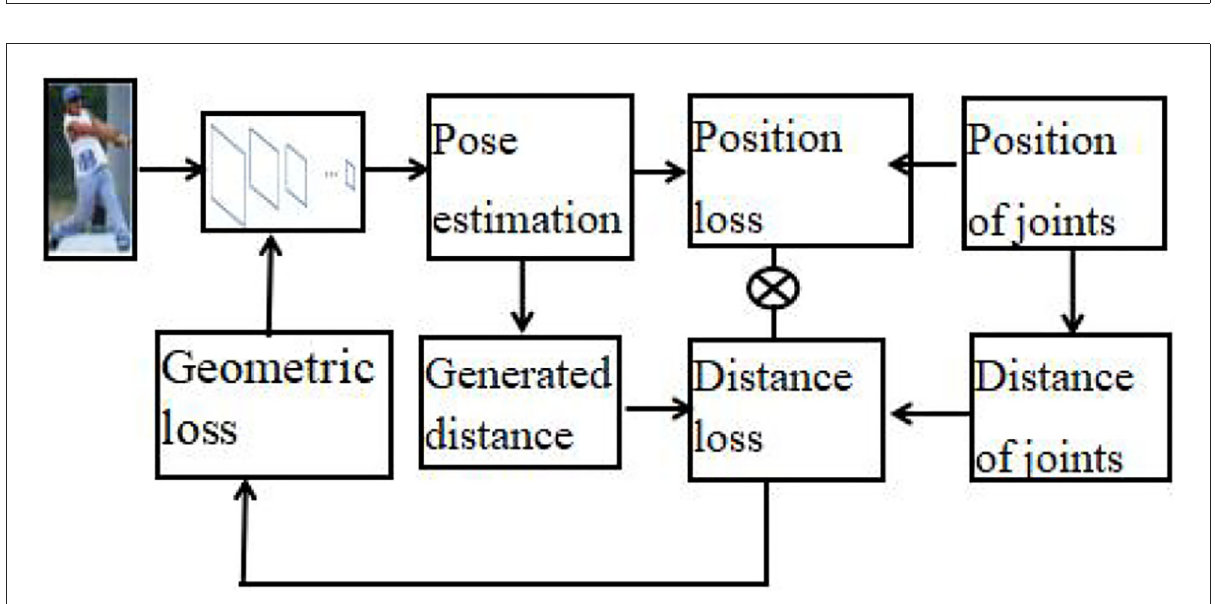
FIGURE3 Geometric constraint-based human pose